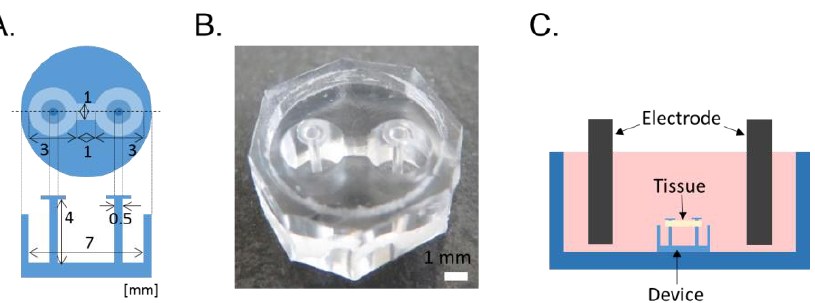
Figure 1. ( A ) Configuration of the microdevice, ( B ) Image of the fabricated device, ( C ) Schematic diagram of skeletal muscle tissue culture and electrical stimulation.